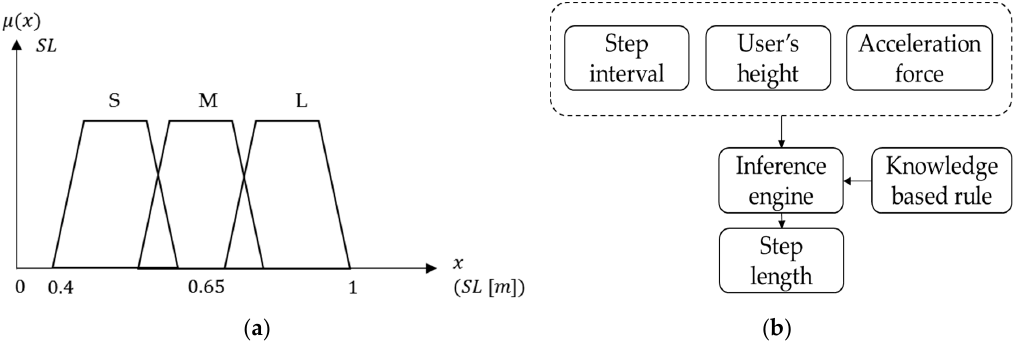
Figure 7. This figure shows fuzzy system of step length: ( a ) The membership function of step length; ( b ) The fuzzy system of step length with input of the three fuzzy sets. Table 1. The example of IF-THEN rules for the fuzzy system of step length.